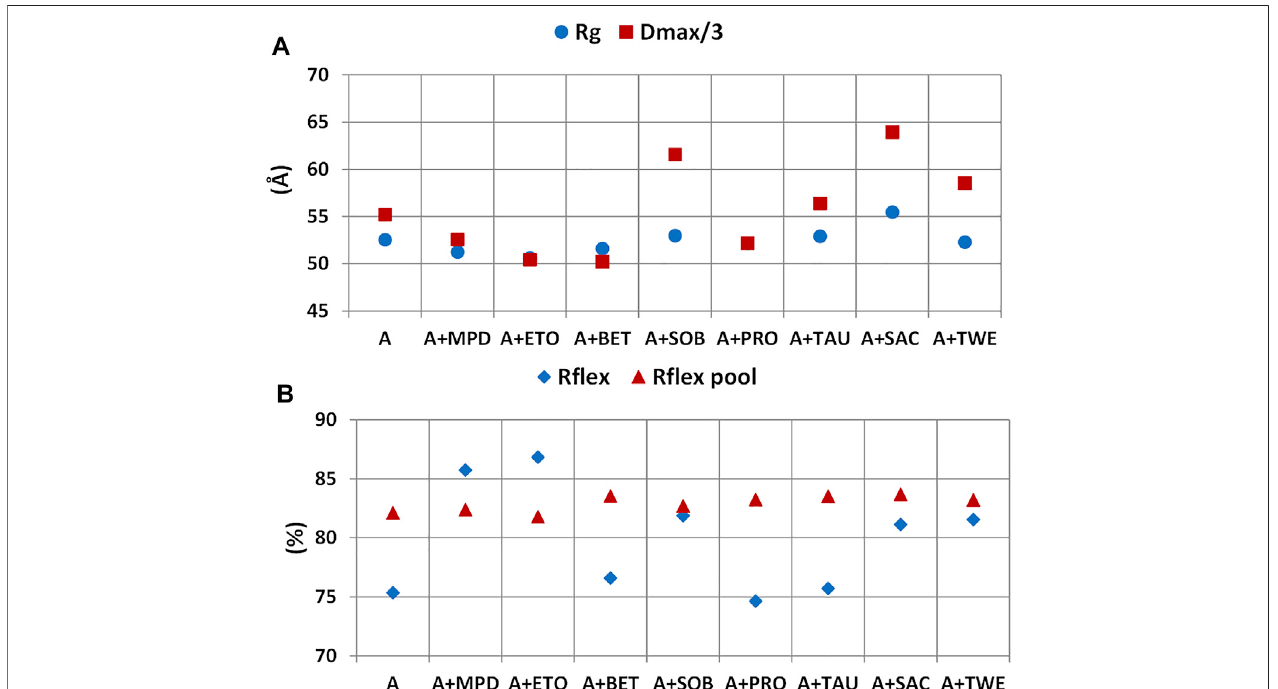
FIGURE 11 | Effect of additives on structural parameters of rituximab derived from SAXS data. Radius of gyration ( R g ) and maximum inter-particle distance ( D max ) (A) and R fl ex fi gure of merit for the generated pool of structures and those selected (B) .